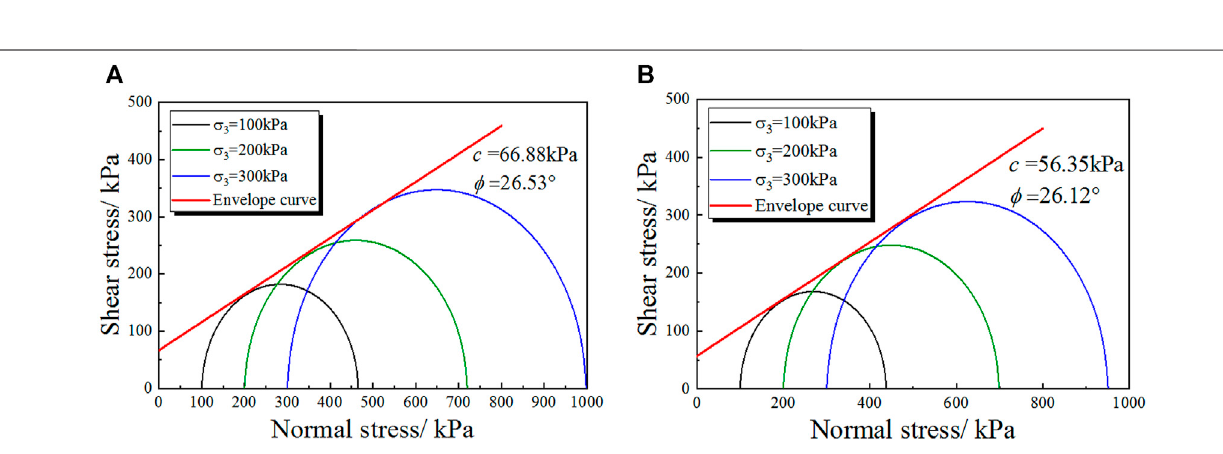
Frontiers in Earth Science |